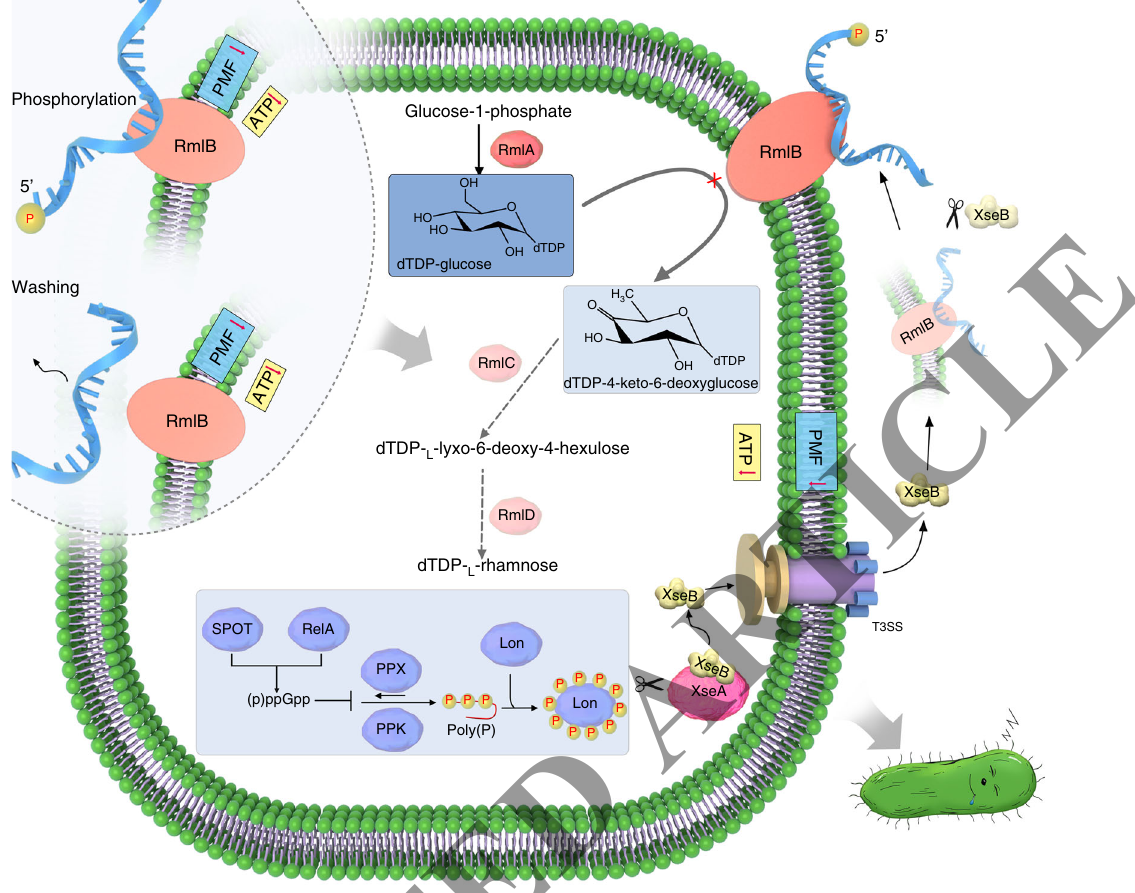
Fig. 6 A proposed model explaining poly(dC)/RmlB-mediated persistence. Activation of RelA or SpoT induces a (p)ppGpp-controlled signaling pathway, which invokes Lon to degrade intracellular exonuclease VII large subunit XseA. Free exonuclease VII small subunit XseB is delivered to extracellular space by T3SS and tailors RmlB-bound poly(dC) to form P-poly(dC), which results in in-situ switch of poly(dC)/RmlB to P-poly(dC)/RmlB. On the other hand, in- situ phosphorylation or washing of PAO1 can bypass the (p)ppGpp-controlled signaling pathway and directly switch poly(dC)/RmlB to P-poly(dC)/RmlB or individual RmlB. In response to the switch in the complex physiological state, cells decrease PMF and intracellular ATP level and shutdown the dTDP- L - rhamnose pathway, forming persistence in